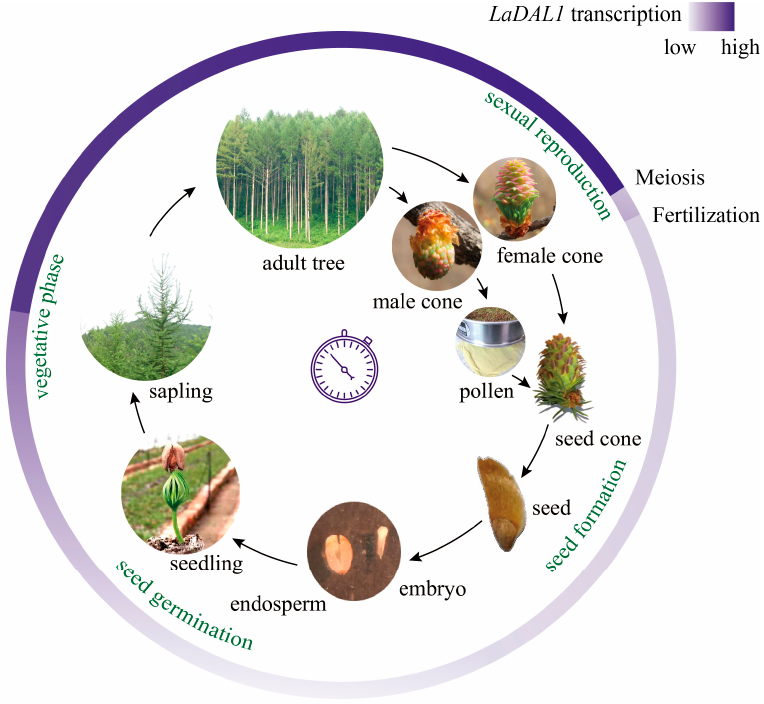
Figure 4. Schematic depicting the life cycle of Larix kaempferi and the expression pattern of LaDAL1 . In this full view of L. kaempferi life cycle, the LaDAL1 transcript level increased from seed germina- tion, then increased sharply in the vegetative phase change, and decreased during meiosis and em- bryogenesis.